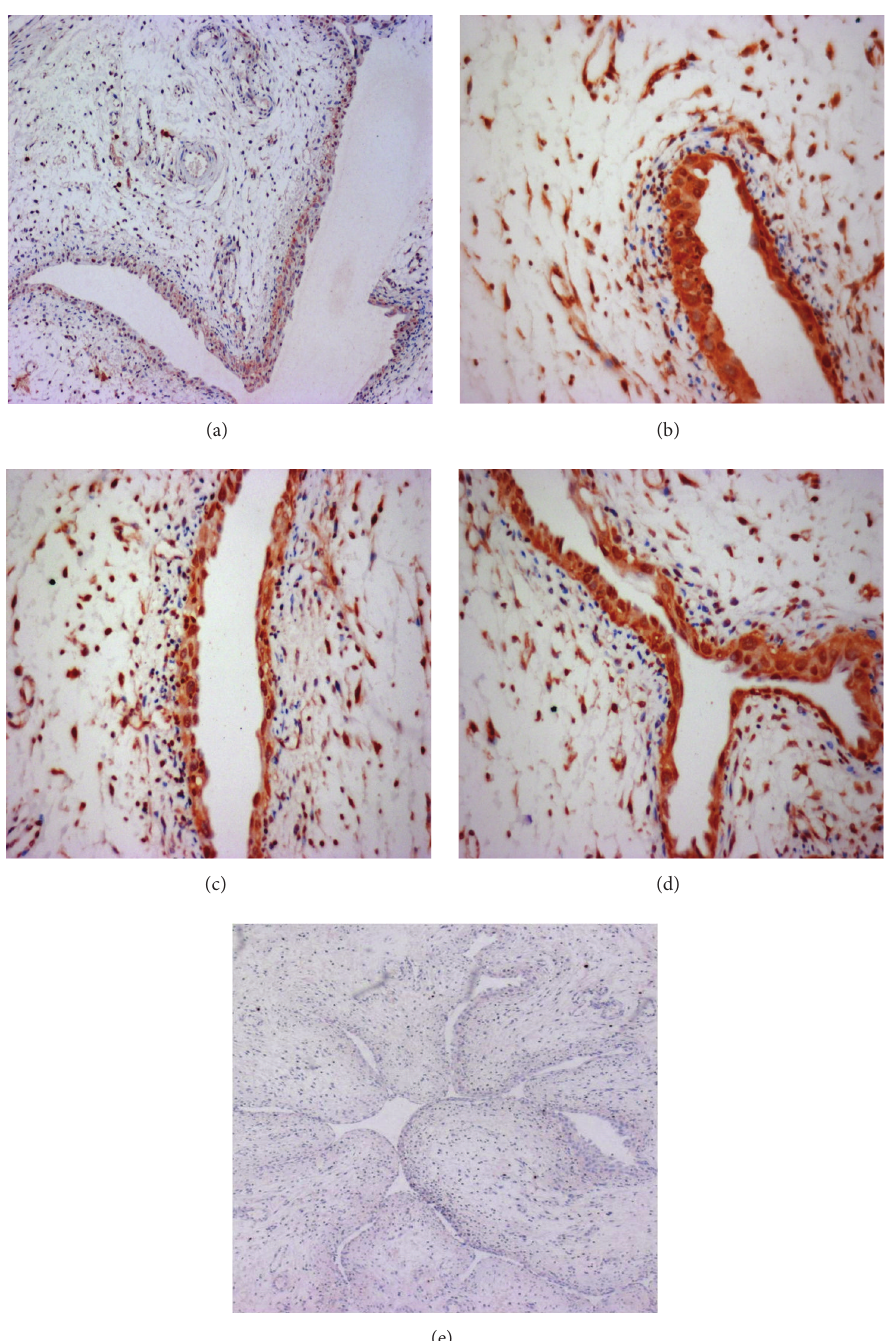
Figure 2: PKR1 immunohistochemical staining in the bladder sections ((a) control; (b) 4 h; (c) 48 h; (d) 8 d). PKR1 protein expression was primarily detected in the urothelium and markedly increased in all rats that suffered from CYP-induced cystitis regardless of duration. (e) A section serves as the negative control incubated with the primary PKR1 antibody absorbed onto the blocking peptide. Sample size 𝑛 = 5–7 for each group. Magnification: (a, b, c, d) 10x; (e)